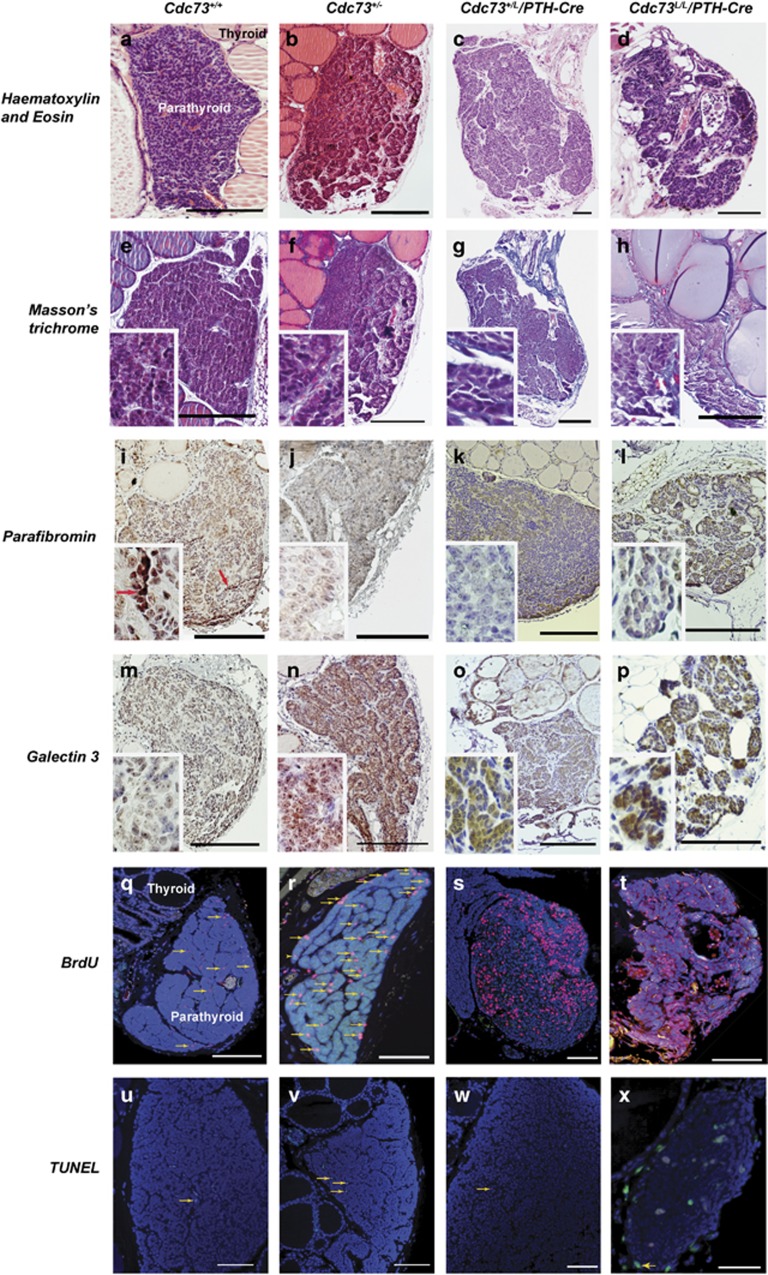
Parathyroid tumours develop in Cdc73+/− and parathyroid-specific Cdc73+/L/PTH-Cre and Cdc73L/L/PTH-Cre knockout mice. (a–d) H&E-stained sections of parathyroid glands from wild-type (Cdc73+/+), heterozygote (Cdc73+/− and Cdc73+/L/PTH-Cre), and homozygote (Cdc73L/L/PTH-Cre) mice, showing: (a) homogenous histology of a wild-type parathyroid; (b) enlarged PA from a Cdc73+/− mouse; (c) a large PA from a Cdc73+/L/PTH-Cre mouse, with increased septation and irregular outline; and (d) abnormal architecture of a parathyroid gland from a Cdc73L/L/PTH-Cre mouse, with increased lipid deposition, nodularity, necrosis and septation. (E-H) Masson’s trichrome stained sections of parathyroids of each genotype demonstrating collagen (blue), and increased fibrous septation in Cdc73+/−, Cdc73+/L/PTH-Cre and Cdc73L/L/PTH-Cre mice when compared to Cdc73+/+ mice. (i–l) Nuclear parafibromin protein expression (brown) in parathyroids was absent or reduced in Cdc73+/−, Cdc73+/L/PTH-Cre and Cdc73L/L/PTH-Cre mice (j–l), when compared to Cdc73+/+ mice (i) (a cluster of parafibromin expressing cells is indicated by the red arrow in panel and inset). Importantly, nuclear parafibromin expression was not reduced in pancreatic exocrine and exocrine cells, endothelial cells and thyroid epithelial cells of Cdc73+/L/PTH-Cre and Cdc73L/L/PTH-Cre mice, thereby confirming the parathyroid-specific loss of Cdc73 expression resulting from the presence of PTH-Cre (Supplementary Figure 3). (m–p) Galectin-3 protein expression (brown cytoplasm) in parathyroids was increased in Cdc73+/−, Cdc73+/L/PTH-Cre and Cdc73L/L/PTH-Cre mice (n–p), when compared to Cdc73+/+ mice (m). (q–t) Assessment of parathyroid tumour proliferation by immunofluorescent BrdU incorporation, by continuous administration of BrdU in drinking water, showing that: (q) few parathyroid cells had proliferated in Cdc73+/+ mice; but that (r–t) higher proportions of parathyroid cell nuclei had incorporated BrdU in the parathyroid tumours of Cdc73+/−, Cdc73+/L/PTH-Cre and Cdc73L/L/PTH-Cre mice. (s) A rim of normal parathyroid tissue, to the left of the image, had low proliferation, whilst the tumour nodule demonstrated focal areas with a high proportion of nuclei that had incorporated BrdU. BrdU-containing nuclei (red, arrows) indicate cellular proliferation; DAPI nuclear counterstain (blue). (u–x) Assessment of apoptosis by TUNEL assay. Apoptotic cells (green nuclei, arrows) were infrequently observed in parathyroids from mice of each genotype; DAPI nuclear counterstain (blue). Scale bars represent 200 μm; insets have x400 magnification.